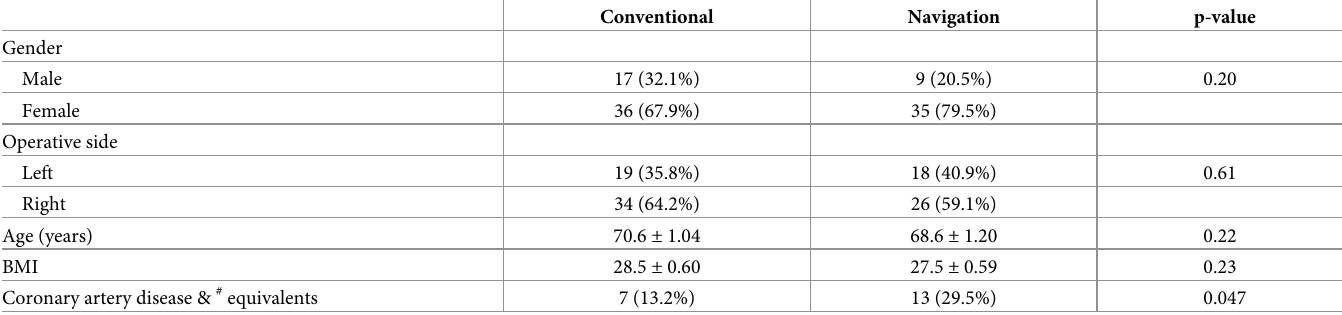
Table 1. Baseline characteristics of patients undergoing conventional or computer-assisted navigation TKA.